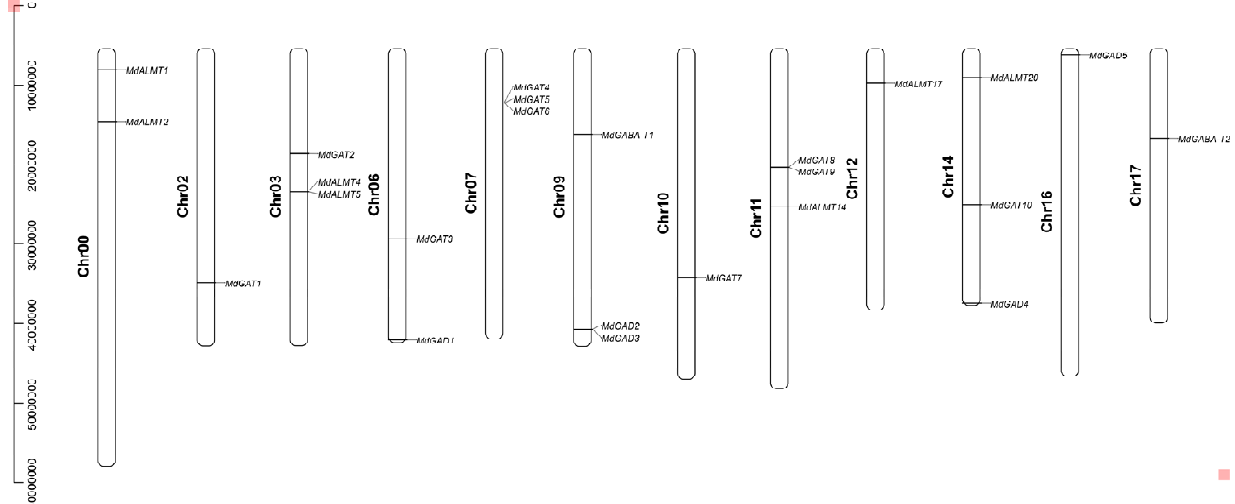
Figure 1. Chromosome distribution of the GABA pathway genes in apple.